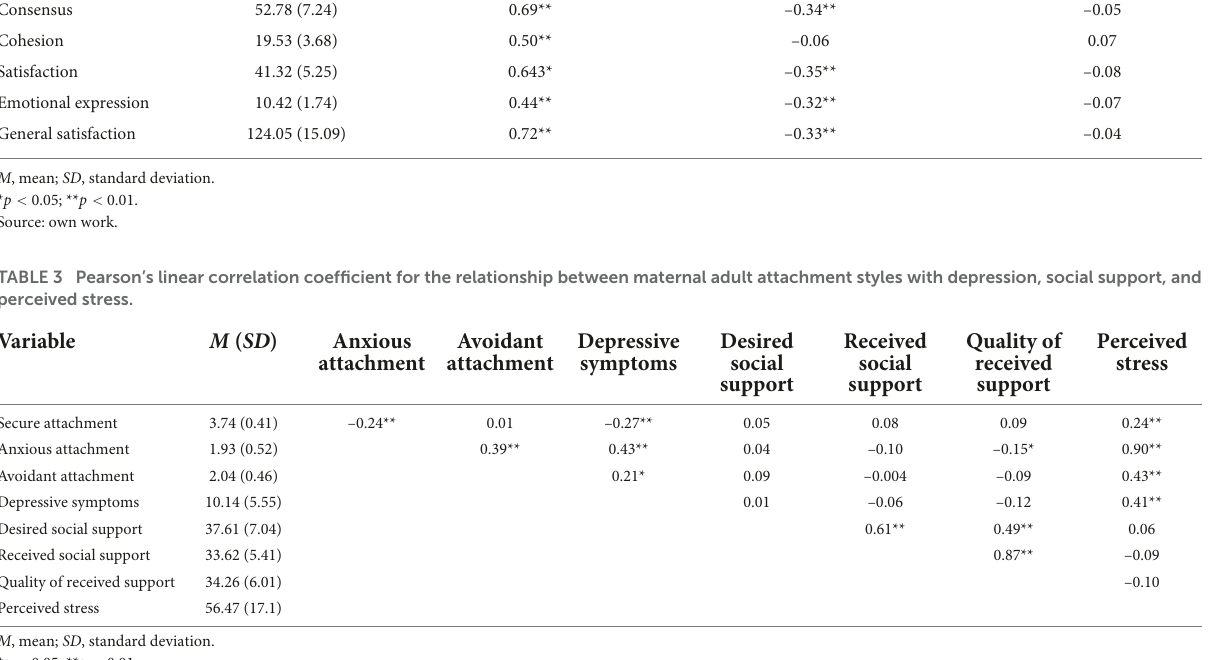
TABLE 2 Pearson’s linear correlation coefficient for the relation between general satisfaction with the relationship quality and its components with maternal adult attachment. Variable